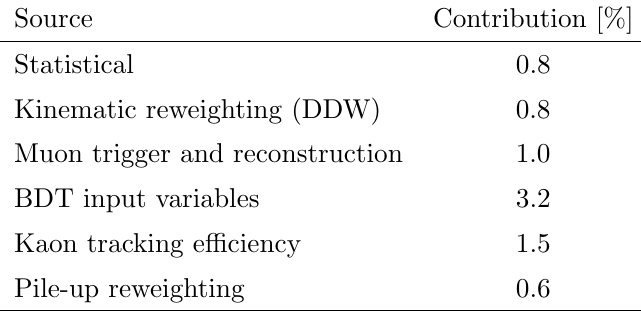
Table 2. Summary of the uncertainties in R "